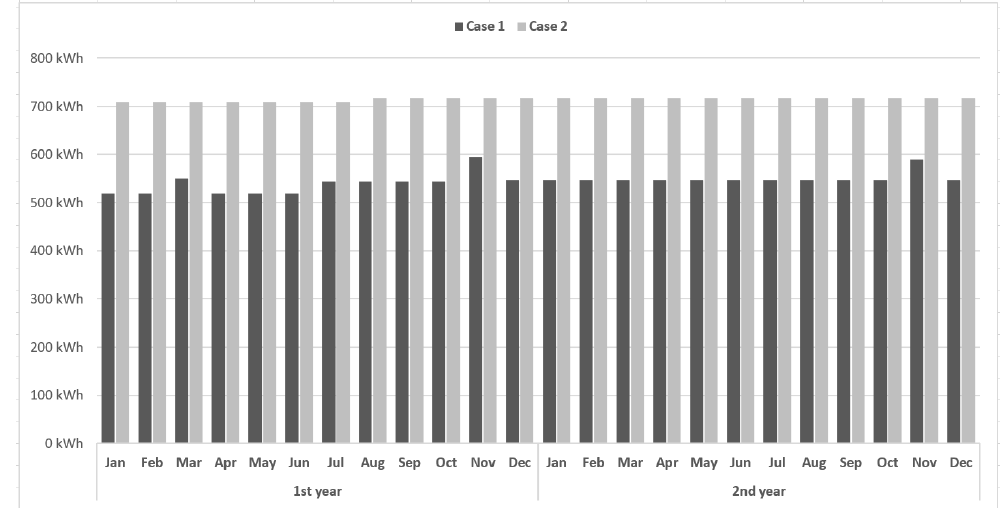
Figure 4. The peak demand of unit time applicable to the monthly base rates in Case 1 and Case